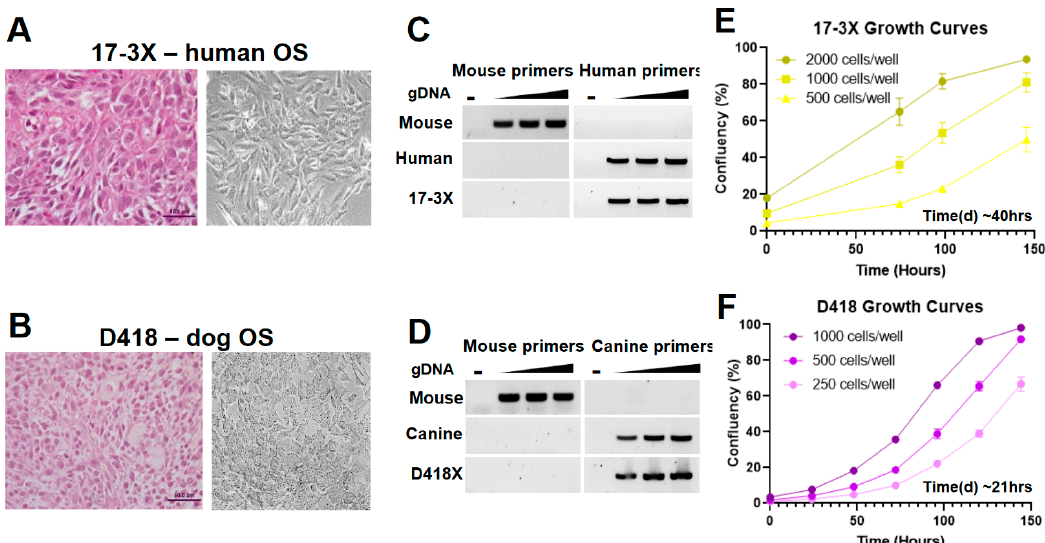
Figure 2. Cross-species analysis of drug activity reveals remarkable similarity in response. ( A ) Establishment of matched patient-derived xenografts and cell lines from human (17-3X) and ( B ) dog (D418) osteosarcomas. ( C , D ) Species-specific PCRs are used to verify the cell lines are purified cancer cell lines devoid of mouse fibroblast contamination. ( E ) The estimated doubling times for the 17-3X and D418 cell lines are approximately 40 and ( F ) 21 h, respectively.